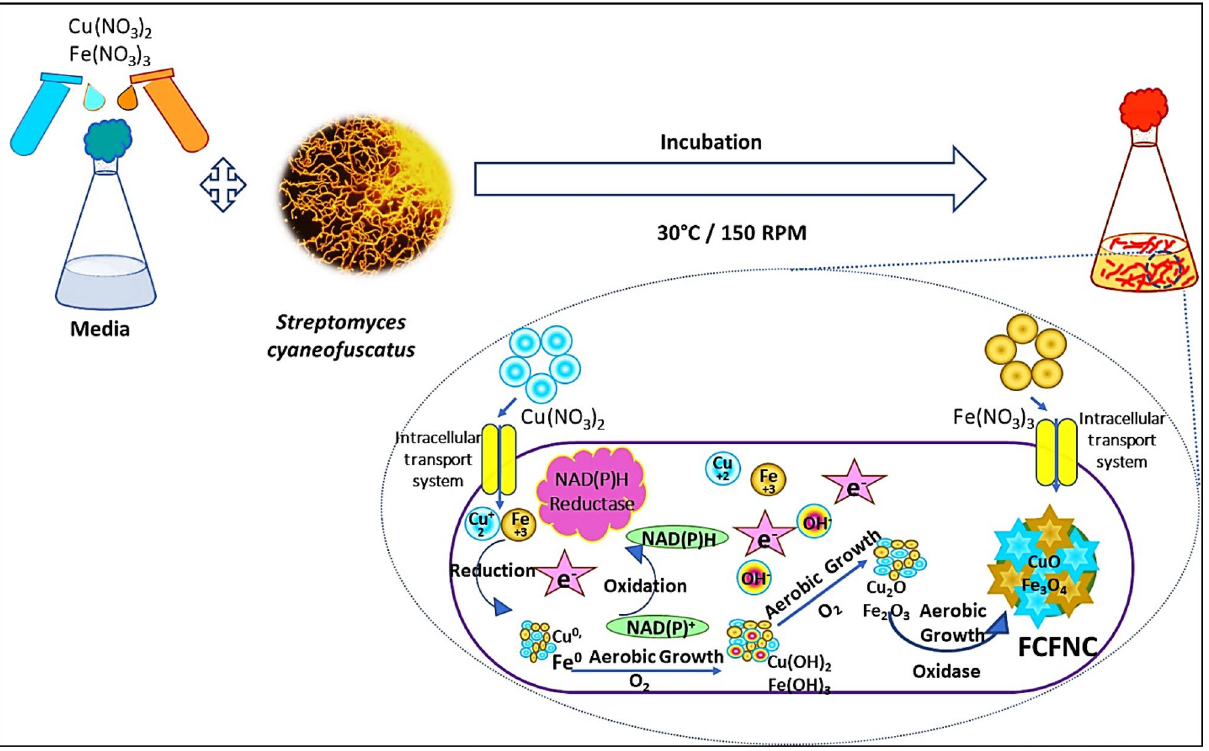
Figure 2. Schematic diagram representing the biosynthesis process of FCFNCs via S. cyaneofuscatus EM3 in presence of Cu(NO 3 ) 2 and Fe(NO 3 ) 3